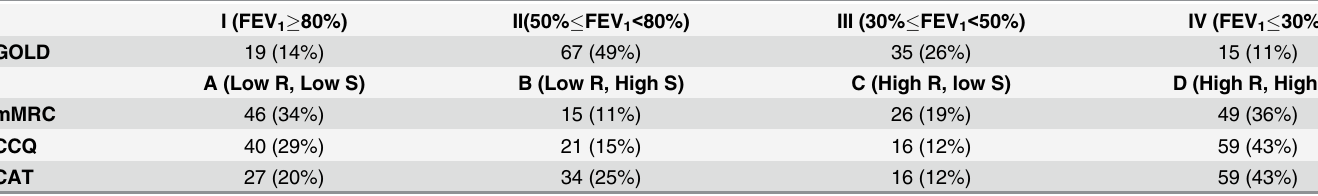
Low S = less symptoms; High S = more